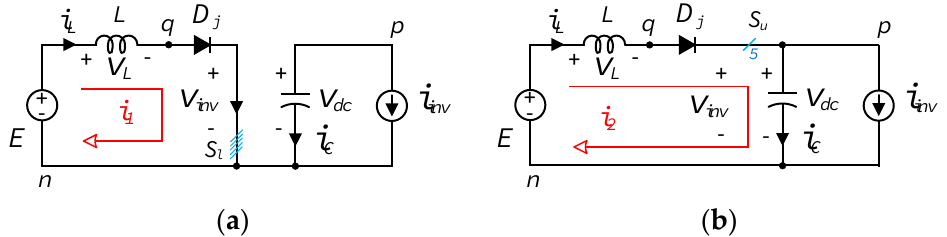
Figure 9. Operating modes of five-phase SSI. ( a ) Inductive charging (for states 0-30). ( b ) Inductive discharging (for state 31).